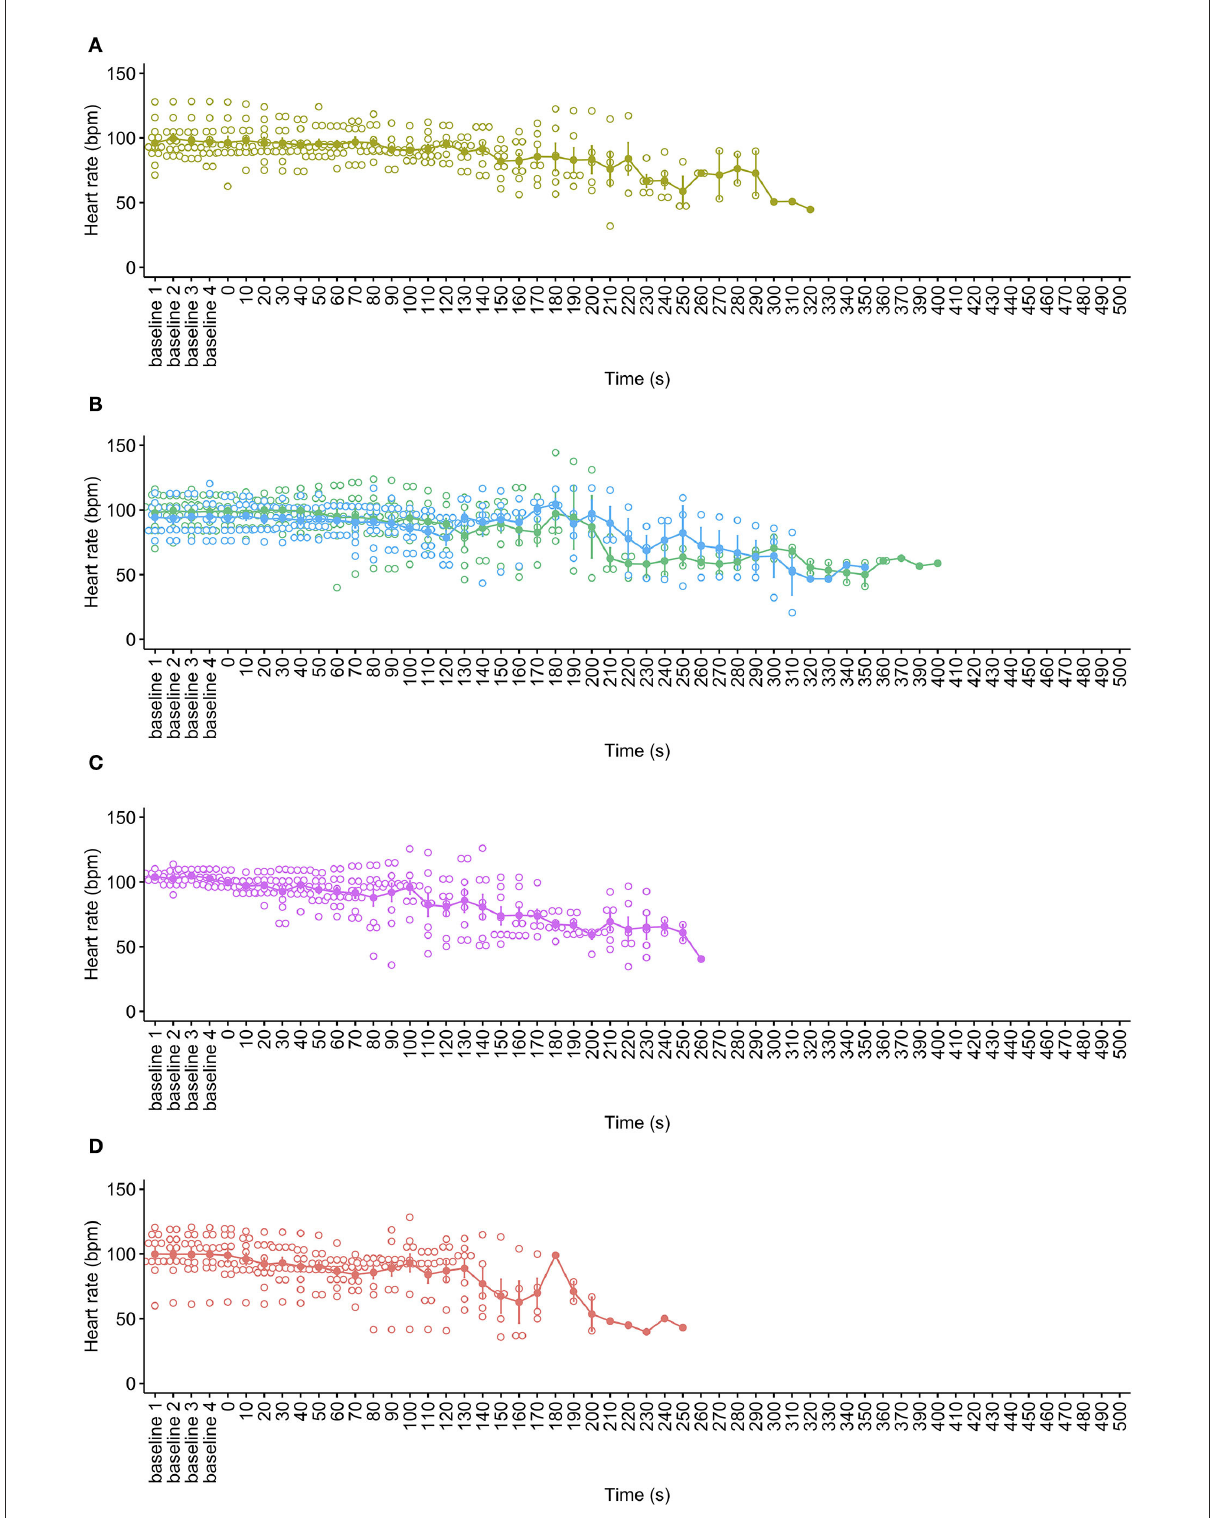
FIGURE3 Mean ± SE heart rate (beats per minute) over time for each decompression treatment rate: (A) 40 ms − 1 (yellow); (B) 60 ms − 1 long/720s cycle (green) and 60 ms − 1 short/480s cycle (blue); (C) 80 ms − 1 (pink); and (D) 100 ms − 1 (red). Mean is represented by solid dots and with error bars for SE, with hollow dots representing individual raw data points. The x-axis has been limited to the baseline period and 500s into the decompression cycles only. Individual HR data were omitted post cardiac arrest, defined by permanent loss of mechanical cardiac activity, represented by the time at which the pulse volume contour on the pulse plethysmograph became permanently